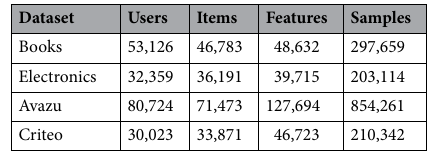
Table 1. Basic statistics of the